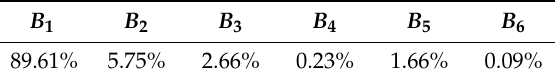
Table 10. E ff ect of benefit functions on the